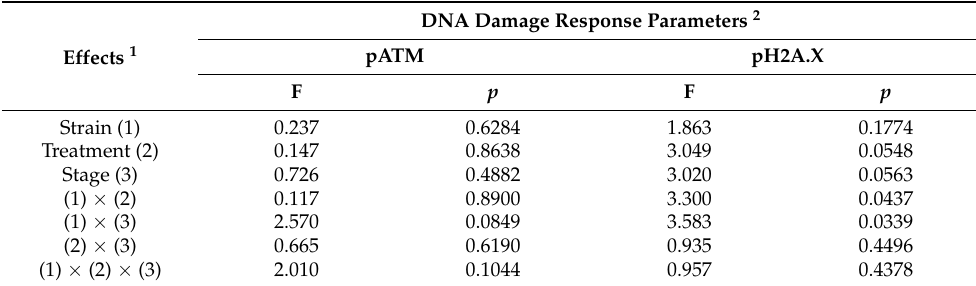
Table 2. The main effects and interactions of the factors: Strain, Treatment, and Stage on DNA damage response parameters in the cells of Acheta domesticus